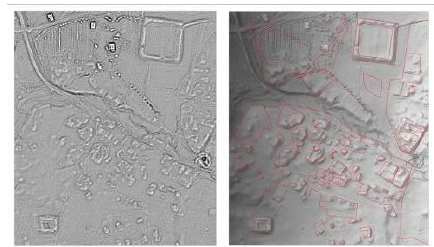
Figure 20 - A Digital Elevation Model (GSD 0,2m) derived from RPAS data set of the Makhmúr al-Qadima site with overlaid objects of interest on the right picture.